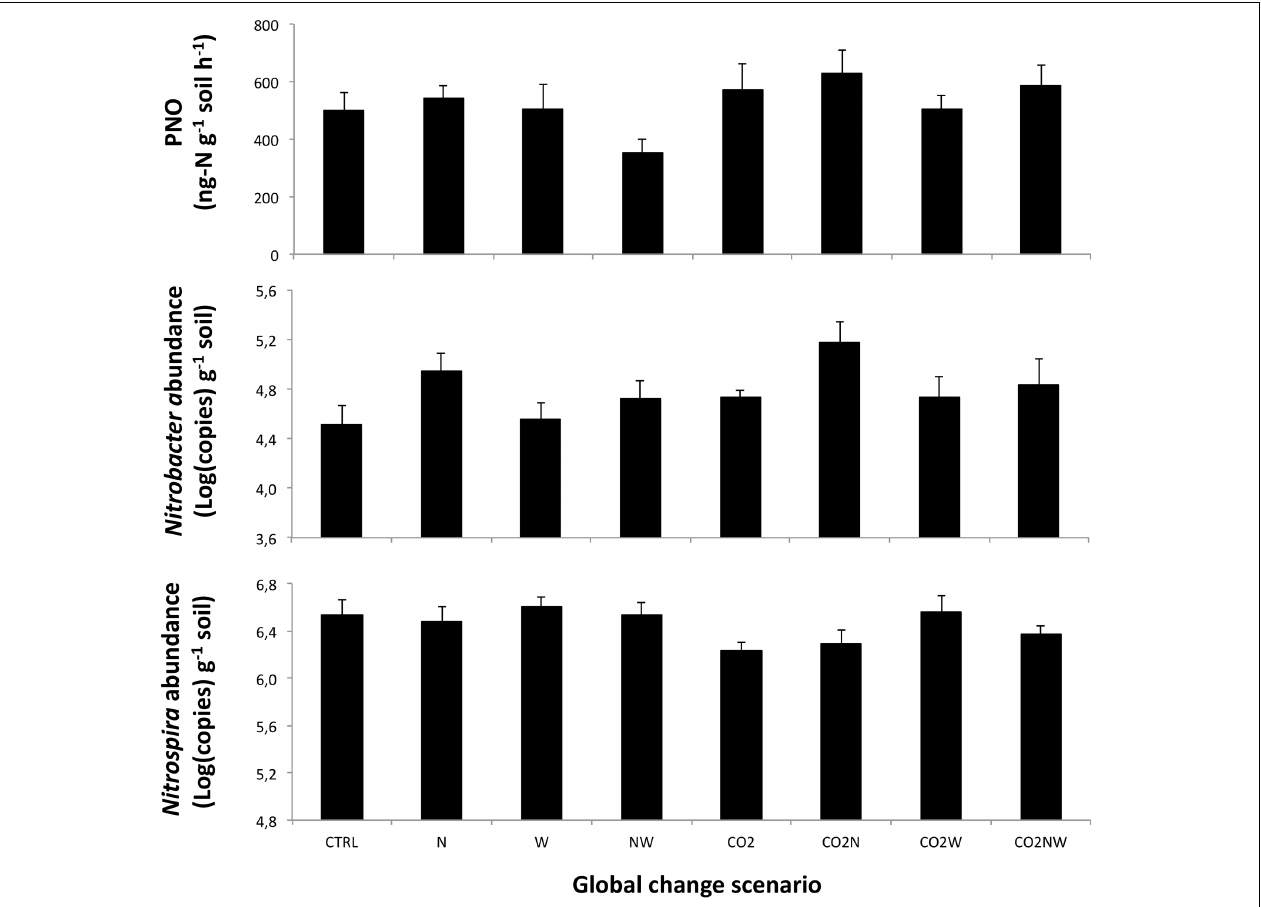
FIGURE 1 | Observed responses of (Top) potential nitrite oxidation, PNO, (Middle) the abundance of total Nitrobacter -like NOB, and (Bottom) the abundance of Nitrospira in response to the different global change scenarios in April 2005. Means are presented with standard errors ( n = 6). N, W and CO 2 refer to nitrogen addition, increased precipitation, and elevated atmospheric CO 2 , respectively. CTRL refers to the control treatment where all factors are at ambient levels. Results of statistical analyses of treatment effects are presented in Table 1